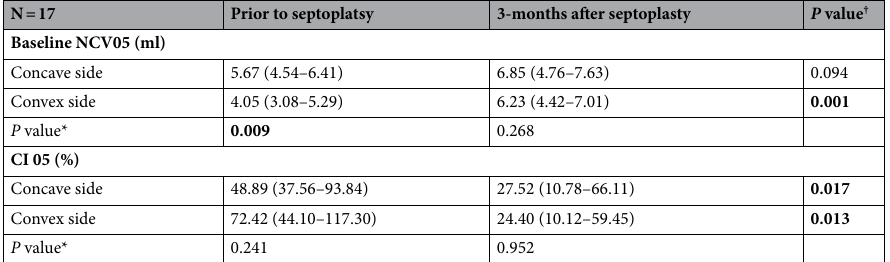
Table 2. Acoustic rhinometry measurements: changes in the intranasal volume, and congestion index following septoplasty. Significant values are in bold. NCV 05 Nasal Cavity Volume of 0 to 5 cm from the nostril, CI 05 congestion index of 0 to 5 cm from the nostril, calculated as following; [(NCV 05 After Decongestion − Baseline NCV 05)/Baseline NCV 05] × 100 (%). All values are shown in median (interquartile range). *P value calculated by using the Wilcoxon signed rank test between the convex side and the concave side of the nasal cavity. † P value calculated by using the Wilcoxon signed rank test between the pre-operative and post-operative acoustic rhinometry